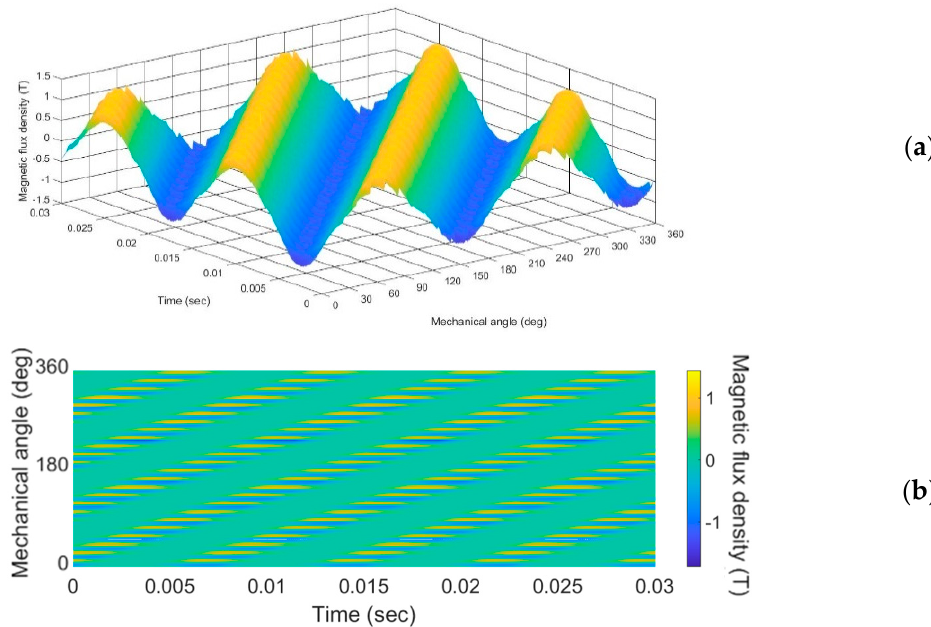
Figure 9. Distribution of magnetic flux density at 2000 rpm. ( a ) 3-D distribution of magnetic flux density. ( b ) 2-D distribution of magnetic flux density.